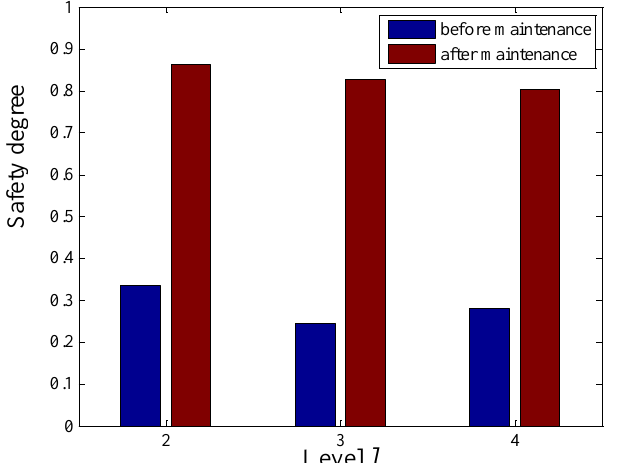
Figure 21. Contrasting operational safety degree before and after maintenance for different